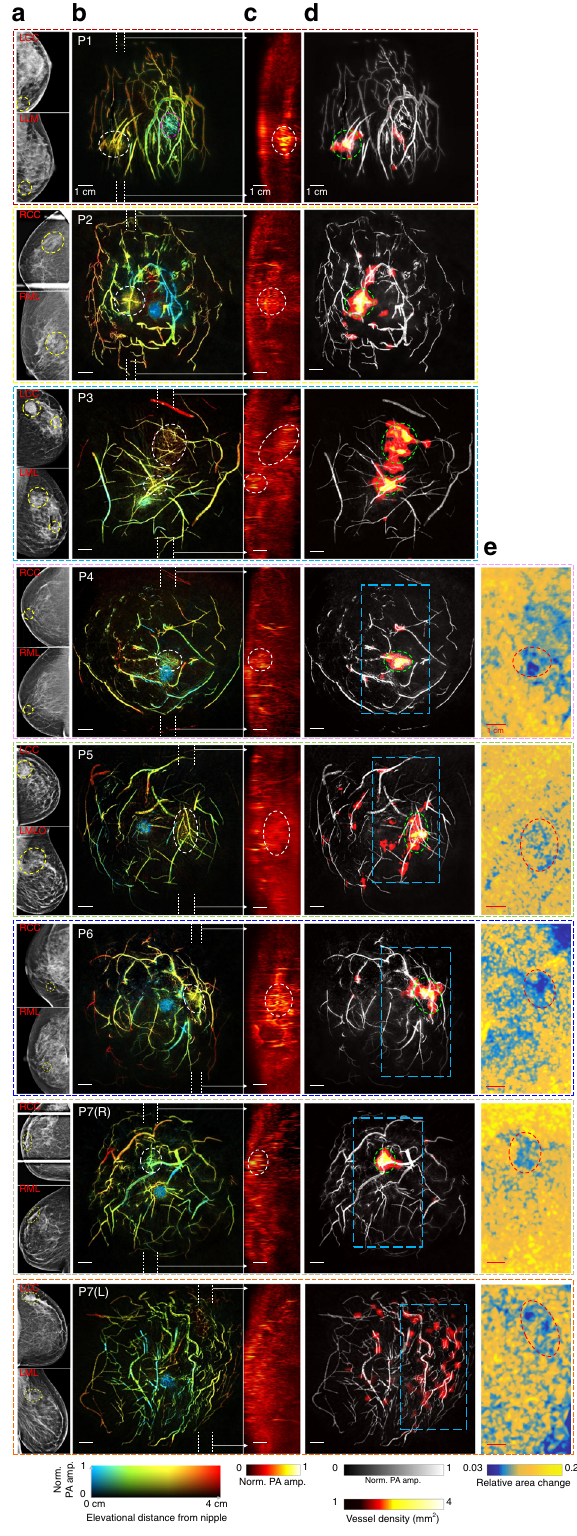
(Supplementary Fig. 8) enabled SBH-PACT to detect breast tumors with fi ne details, making this imaging modality poten- tially useful for multiple applications in breast clinical care. We imaged seven breast cancer patients (Fig. 3), with breast sizes ranging from B cup to DD cup (over 99% of the U.S. population has breast sizes of DD cup or smaller 50 ) and skin